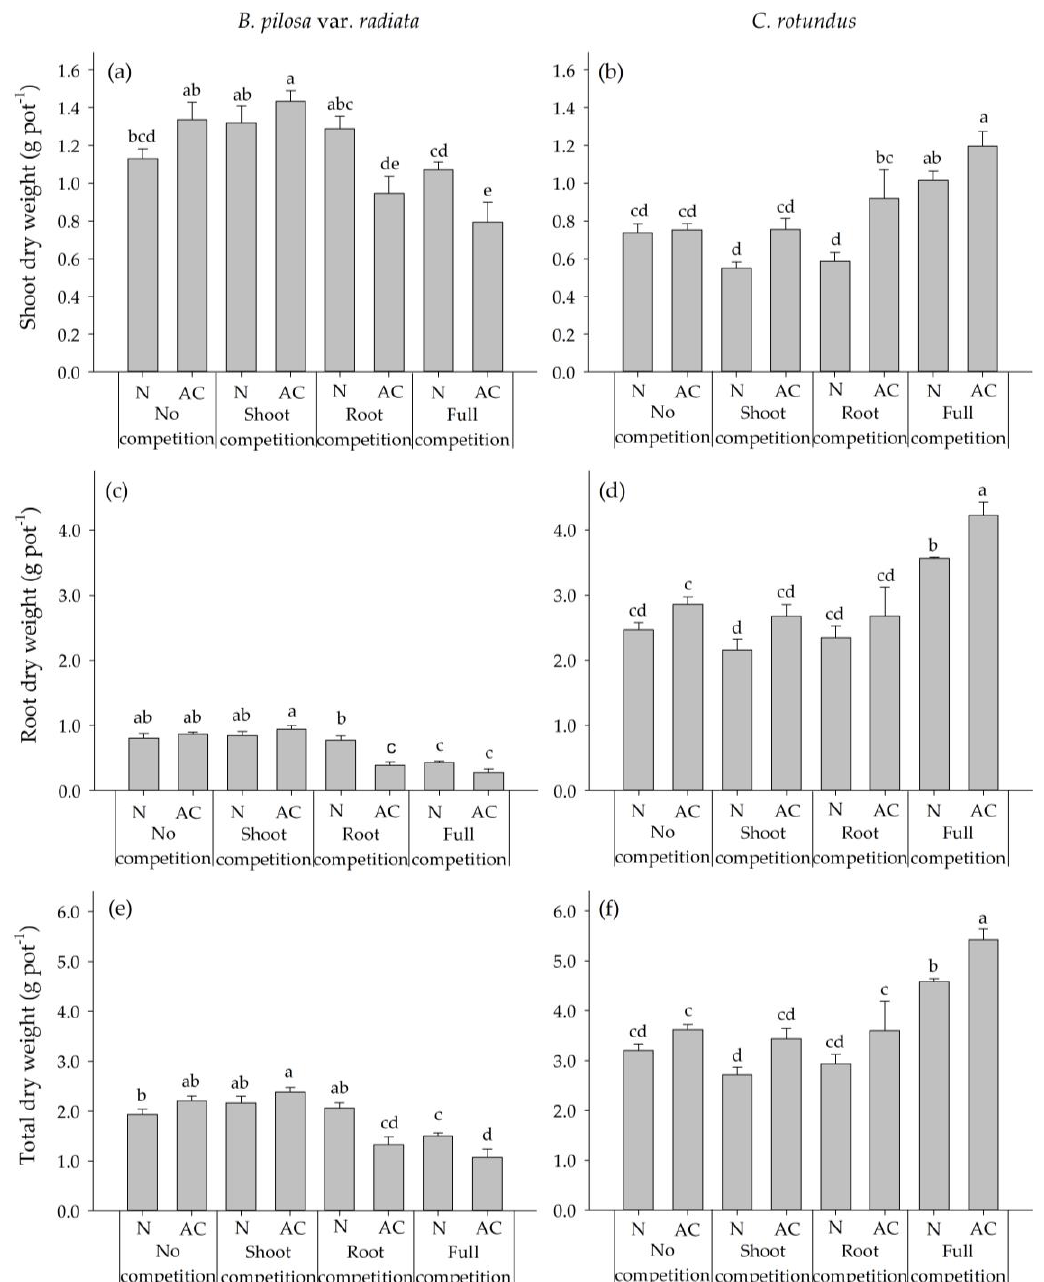
Figure 2. Shoot, root and total dry weight per pot of BPr and CR when grown with two activated carbon application treatments and subjected to four competition modes. ( a ) Shoot dry weight of BPr . ( b ) Shoot dry weight of CR . ( c ) Root dry weight of BPr . ( d ) Root dry weight of CR . ( e ) Total dry weight of BPr . ( f ) Total dry weight of CR . AC and N denoted pots added with and without activated carbon application, respectively. Error bars are the standard error of mean ( n = 5). Means with the same letter(s) are not significantly di ff erent at 5% level by LSD